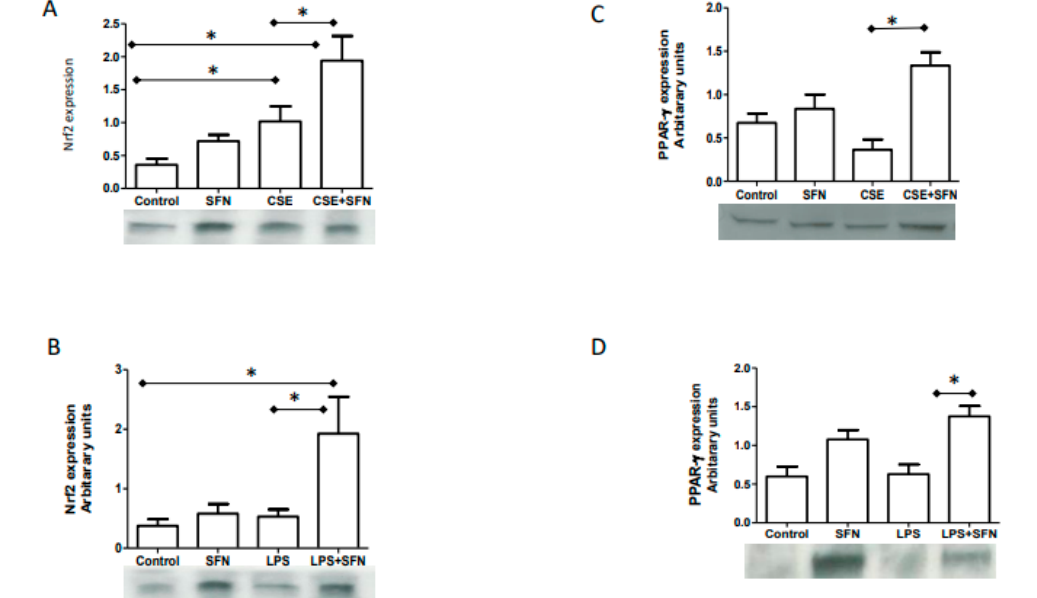
Figure 1. Representative western blots of Nrf2 (100kDa) and PPAR γ (53 kDa) expressions in fetal membranes and graphical representation of data ( n = 6) after 6 h of treatment with various factors.; * p < 0.05. ( A ): Fetal membranes treated with sulforaphane (SFN), cigarette smoke extract (CSE) and CSE + SFN. ( B ): Fetal membranes treated with SFN, lipopolysaccharide (LPS) and LPS + SFN. ( C ): Fetal membranes treated with SFN, CSE and CSE + SFN. ( D ): Fetal membranes treated with SFN, LPS and LPS + SFN.